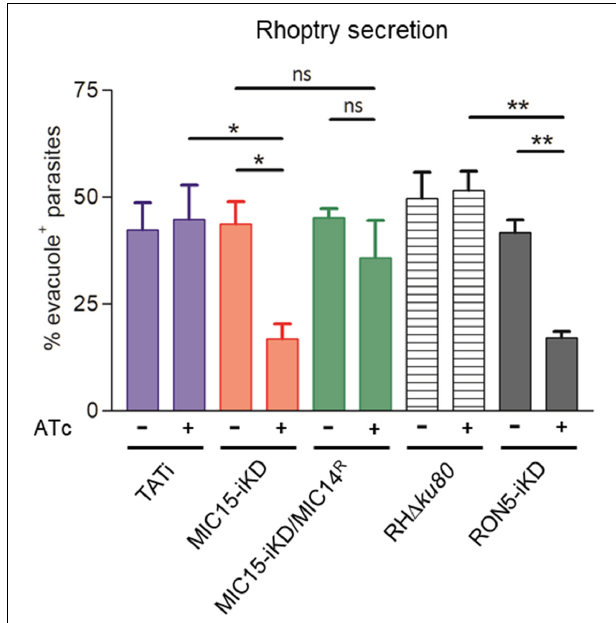
FIGURE 9 | MIC15 and MIC14 are novel components of the rhoptry discharge pathway. Rhoptry secretion assay based on the detection of ROP1 + evacuoles released in the host cell by Cytochalasin D-arrested extracellular tachyzoites. Values represent the percentage of evacuole-associated tachyzoites and are expressed as means ± SEM from three independent experiments performed in triplicate. Statistical significance was determined by the Student’s two tailed t -test. The number of parasites able to produce evacuoles was significantly lower in MIC15-depleted tachyzoites (red bars) compared to the untreated MIC15-iKD control and the parental strain. No statistically significant reduction in evacuole formation was observed in MIC15-iKD/MIC14 R parasites depleted of MIC15 (green bars), demonstrating that MIC14 upregulation is able to functionally compensate the MIC15-dependent rhoptry secretion defect. The strain RON5-iKD defective in rhoptry secretion was used as positive control (gray bars). Based on this evidence, MIC15 and MIC14 are renamed rhoptry discharge factor 1 (RDF1) and rhoptry discharge factor 2 (RDF2), respectively. * p < 0.05, ** p <